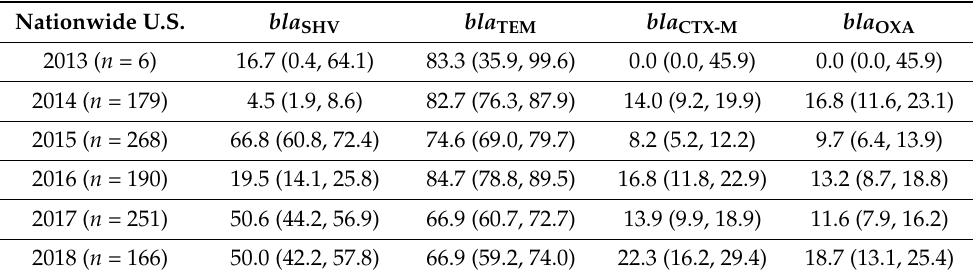
Table 3. The yearly frequency of bla SHV , bla TEM , bla CTX-M , and bla OXA from the U.S. Nationwide Database. Each frequency is presented with a 95% confidence interval. The number of isolates is listed in the first column in